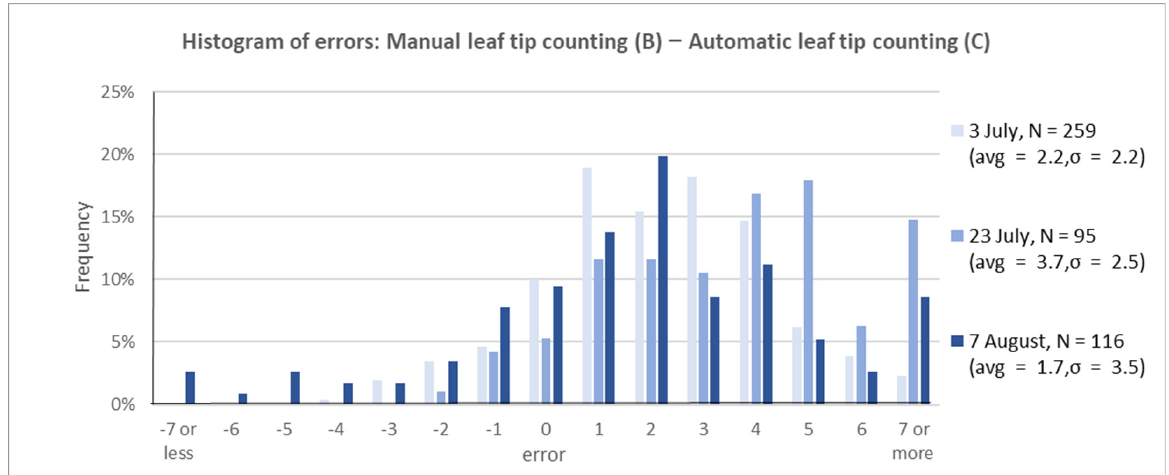
Figure 9. Error histogram between manually and automatically counted leaf-tip numbers.